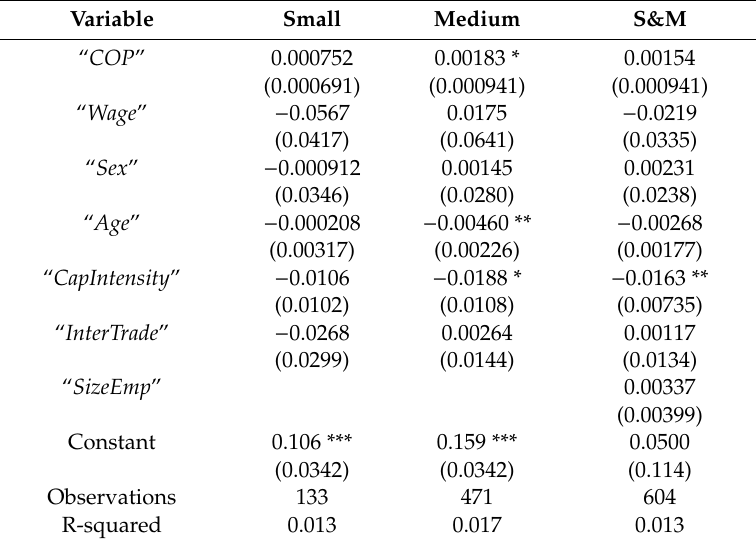
Table A1. Correlates of ROE for small and medium